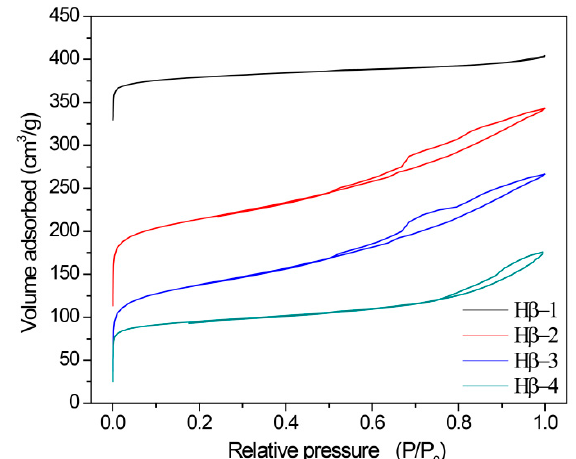
Figure 2. Nitrogen adsorption and desorption isotherms of the catalysts.